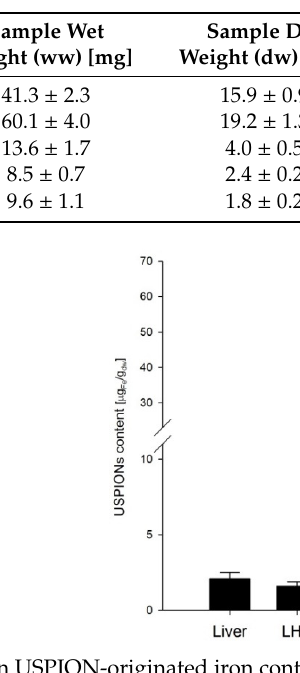
Figure 16. Confidence band around (green lines) of M data of the liver control group (black lines for individual samples) and their mean value (red line). Table 1. Summary of USPION-originated iron content in the tissues and whole blood of rats treated with USPIONs (1 mg/kg i.v., 100 min post-infusion). Mean sample mass is presented as dry and wet weight. Sensitivity of the measurement method is expressed in µg of USPION iron per g of dry sample weight. n is the number of samples where USPION content was determined. Results are presented as mean ± SEM.